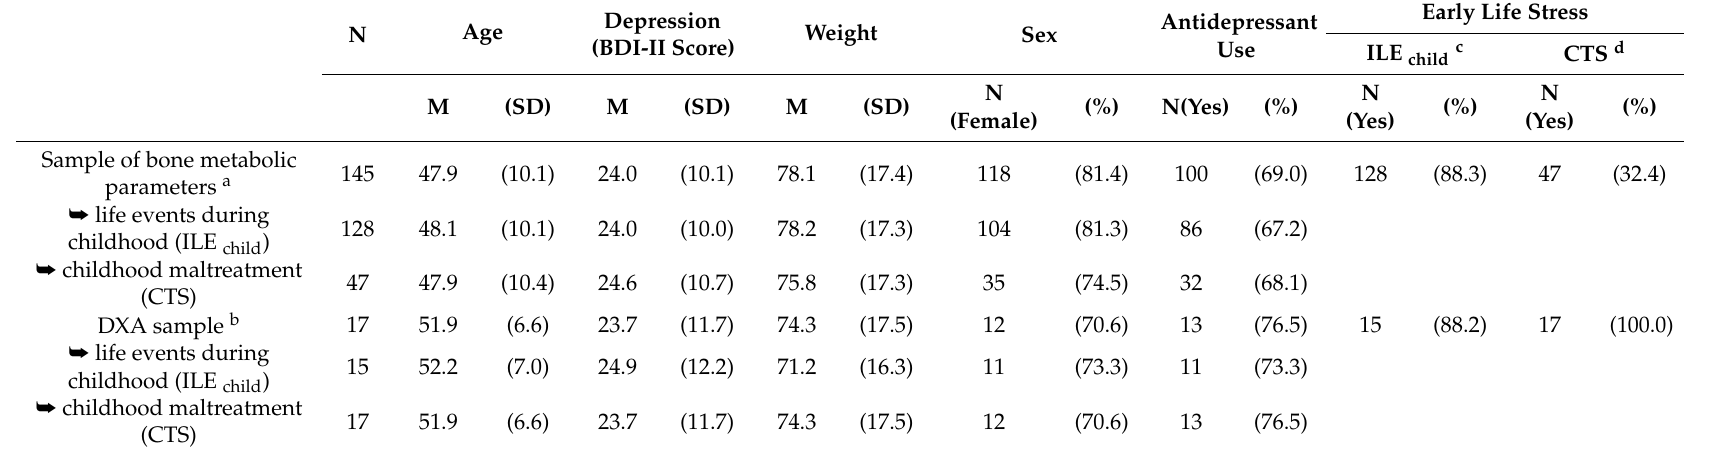
Table 1. Descriptive Data on Sociodemographic and Clinical Characteristics of the Human